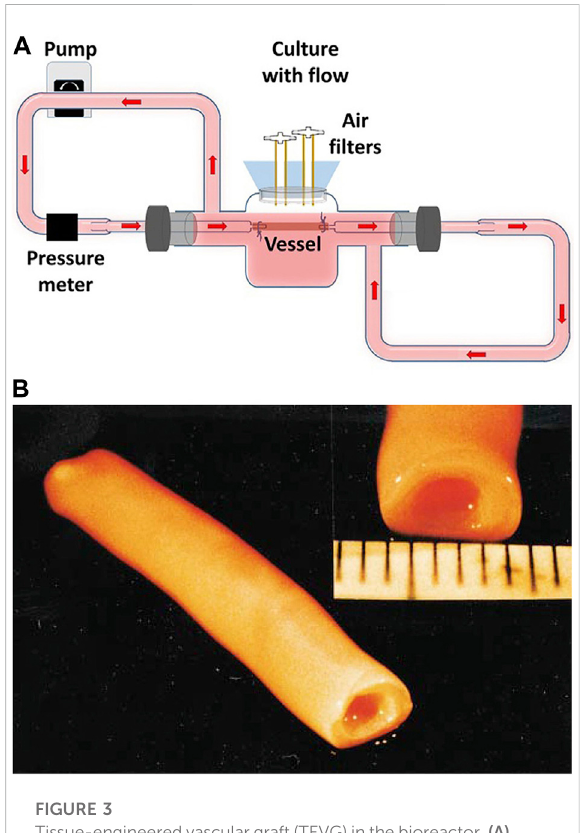
FIGURE 3 Tissue-engineered vascular graft (TEVG) inthebioreactor. (A) Dynamic culture of TEVG in the bioreactor (Kural et al., 2018). (B) Macroscopic view of a mature TEVG (L ’ Heureux et al.,